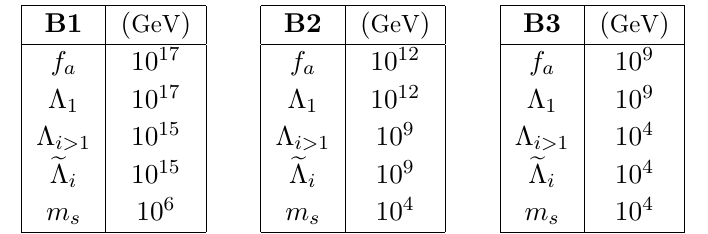
(cid:3) i . With the exception of e